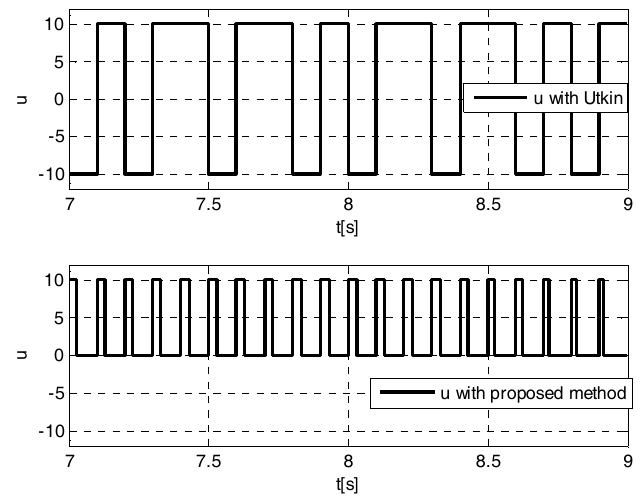
Figure A10. Some details of the control signals in Figures A7 and A9.